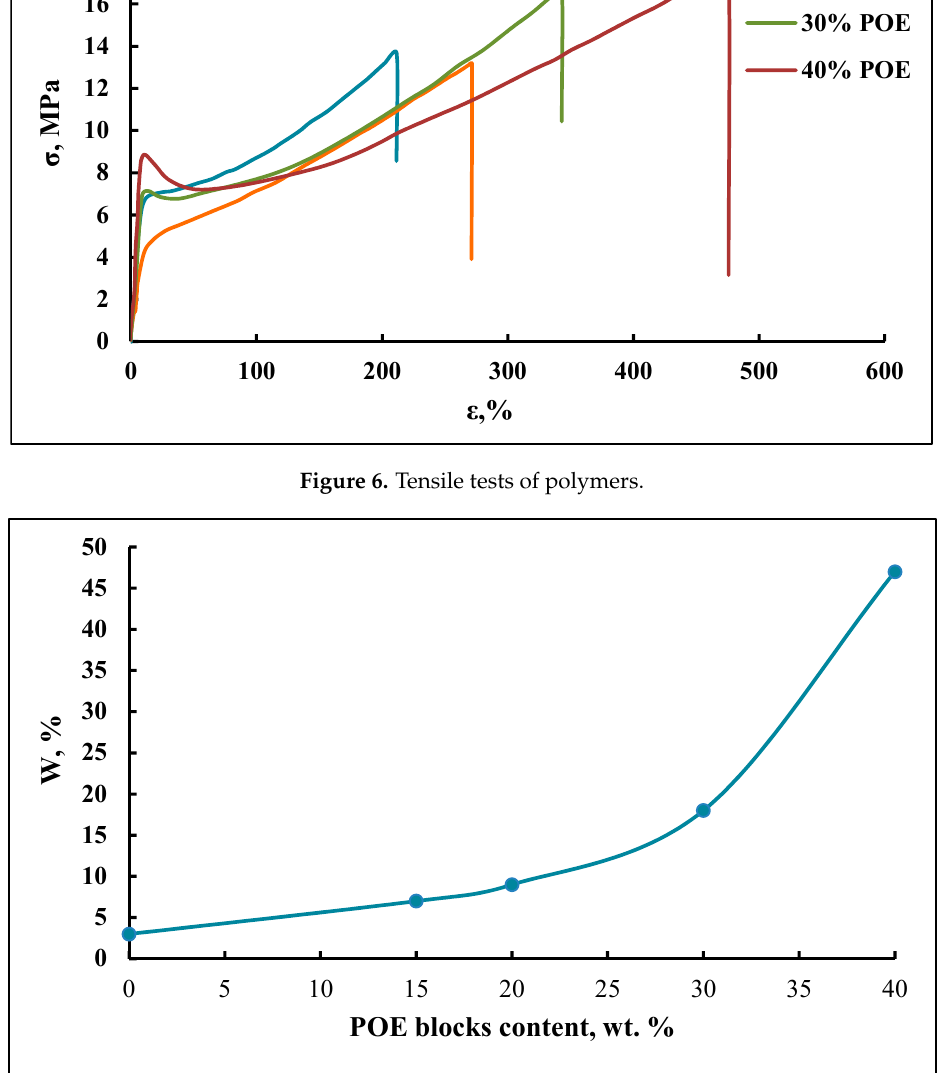
Figure 7. Dependence of the limiting degree of water adsorption (W, %) of polymers on the POE block content (wt %).